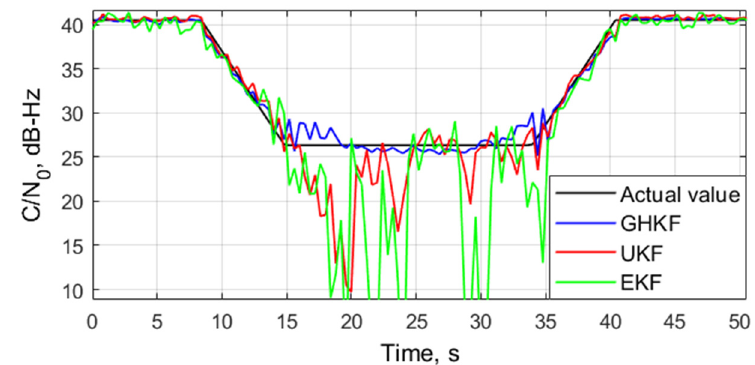
/ C N estimates. Figure 3. The C / N 0 estimates. 0